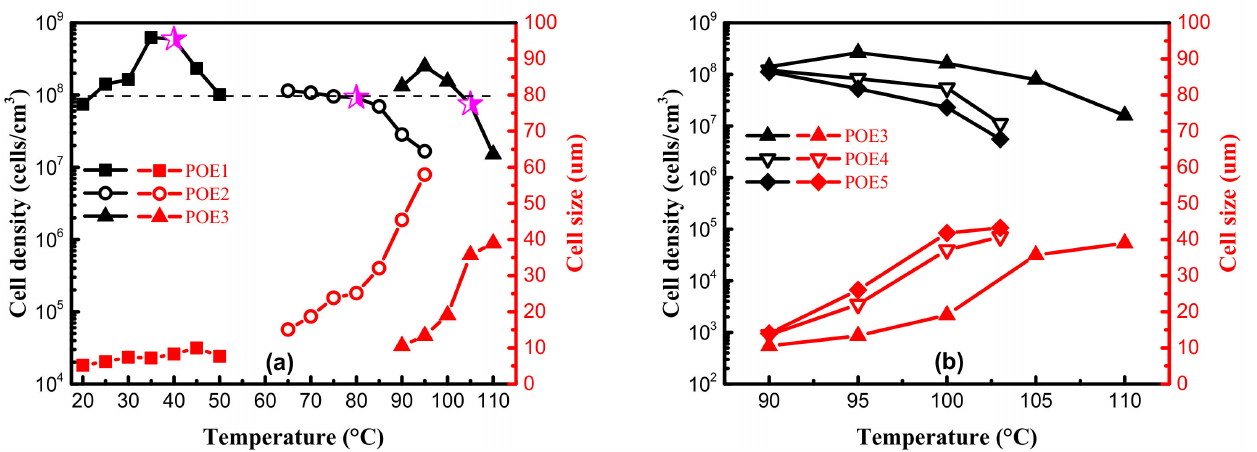
Figure 11. Cell density and cell size of POE foams obtained at different temperature. The data was measured at the aging time of 21 days. ( a ) POE samples with same MI; ( b ) POE samples with same octene content.